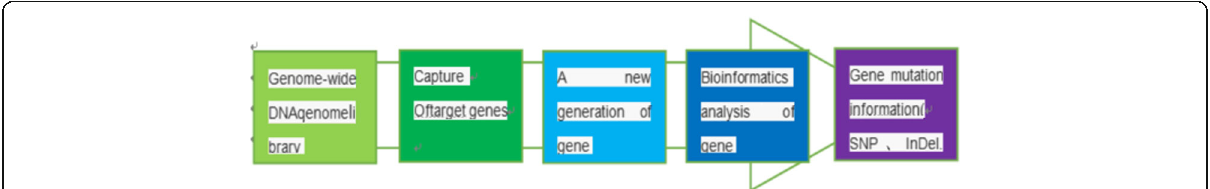
Fig. 2 Process of target region capture the high-throughput sequencing. Screening for mutations in the target genes was performed by next generation sequencing (NGS) (Illumina HiSeq 2500, USA) with ≥ 200-fold average high-throughput sequencing depth; mutations were analyzed by